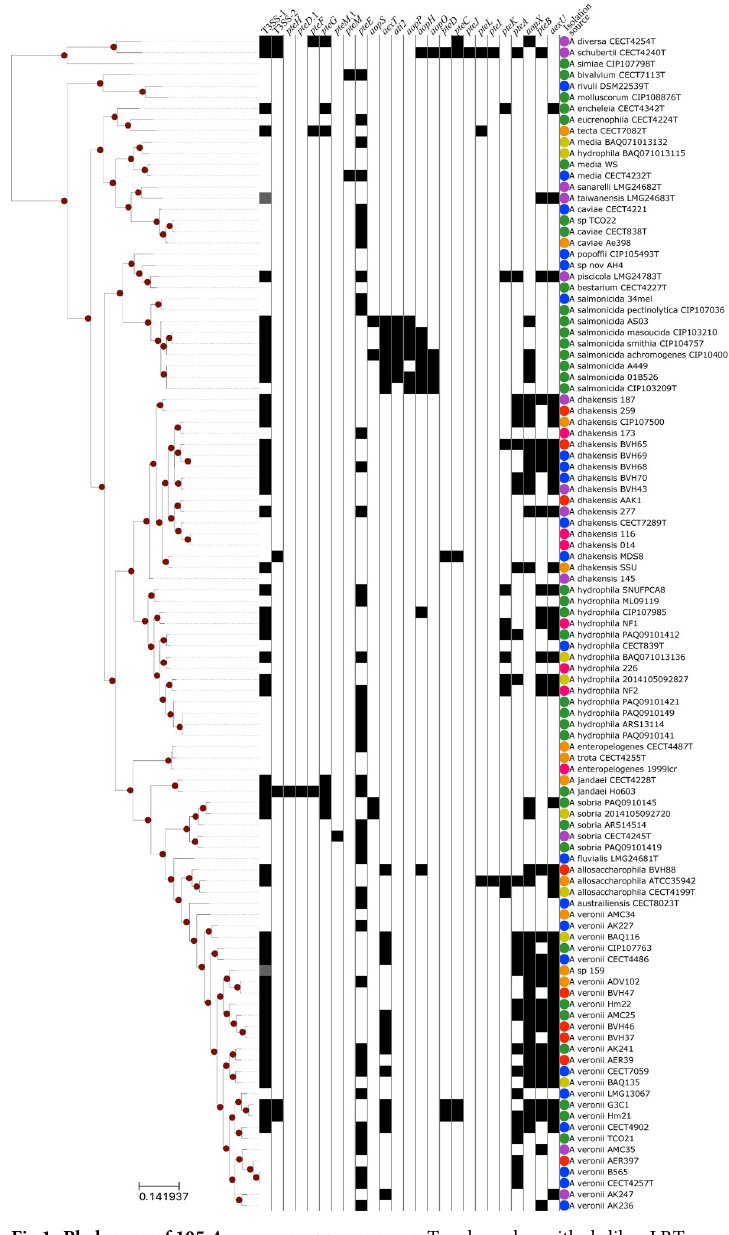
Fig 1. Phylogeny of 105 Aeromonas spp. genomes. Tree branches with sh-like aLRT support of at least 90% are highlighted with red circles. The binary heat map represents the presence/absence of T3SS apparatus and identified putative effectors in Aeromonas spp. isolates. The dark gray squares in the T3SS-1 column denote partial presence of the apparatus due to missing genes. The isolation source colors represent: green, veterinary; yellow, sick veterinary; blue, environment; orange, feces; red, blood; purple, wound; and pink, human. (HMM) profiles generated from each of the 25,518 identified Aeromonas spp. homolog gene families were queried against T3SS sequences from the VFDB, which yielded 633 positive hits (e-value � 1e-10). Although some of these positive hits were clearly not T3SS related they dis- played alignments with e-values as low as 6 e − 155 due to a common origin of other systems shared with T3SS components. Protein sequences from Vibrio fisherii ES114 [46] and